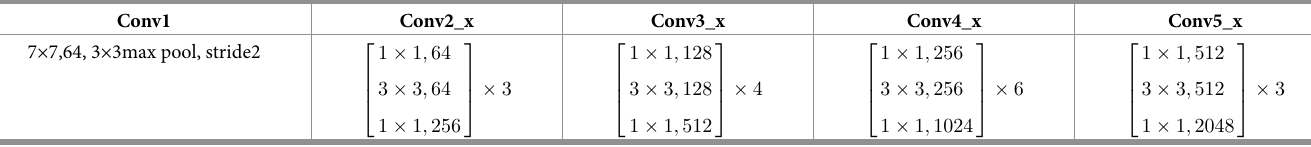
Table 3. Parameter configuration of residual block in conv1-conv5 group. Conv1